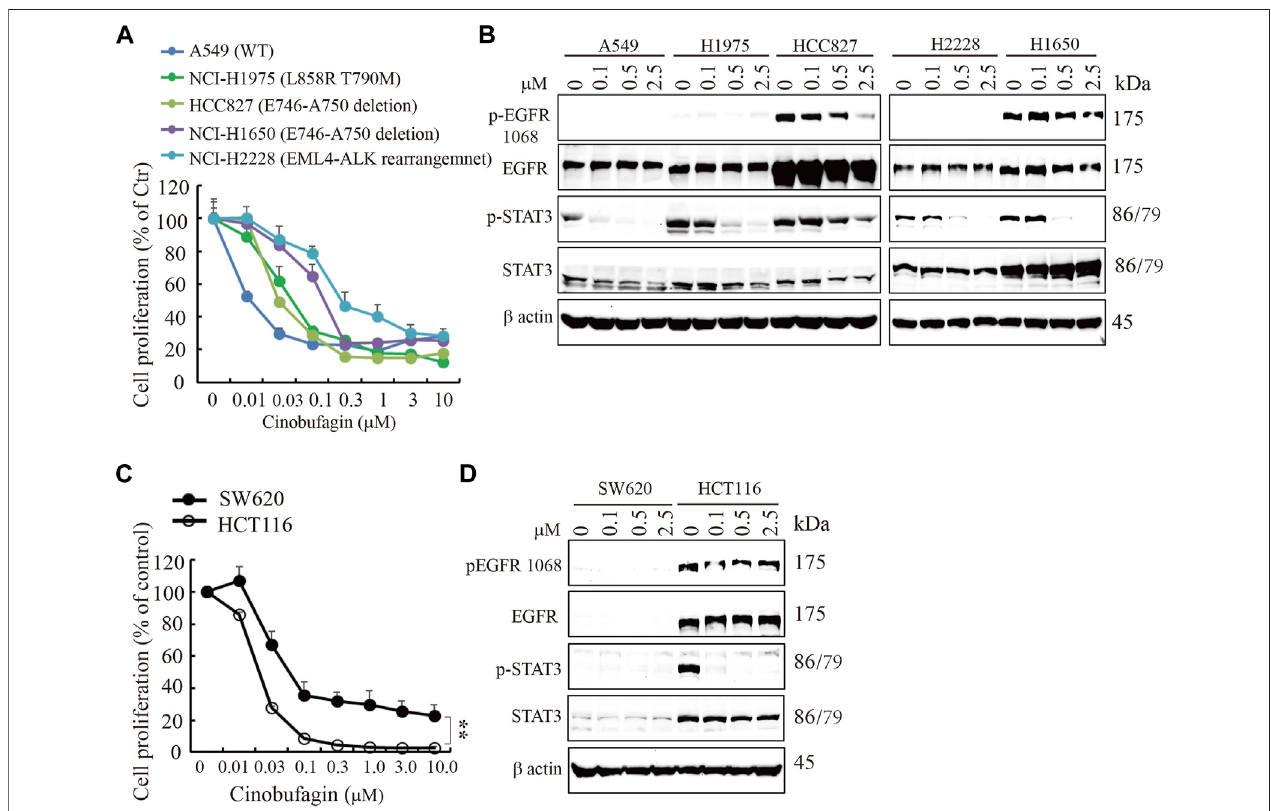
FIGURE 3 | Cinobufagin inhibits proliferation of EGFR expression cancer cells. (A) Cinobufagin inhibits proliferation of non – small lung cancer cell lines with EGFR expression. The non – small lung cancer cell lines with different status of EGFR were treated with a range of doses of cinobufagin for 72 h, followed by CCK8 assay. (B) EGFR expression and its downstream signaling analysis. The non – small lung cancer cell lines were treated with indicated doses of cinobufagin for 6 h, followed by Western blot analysis of EGFR and its downstream molecules. (C) Cinobufagin inhibits proliferation of colorectal cells with EGFR expression. Colorectal cells were treated with cinobufagin for 72 h, then followed by CCK8 assay. (D) EGFR expression and its downstream signaling analysis by Western blot. Colorectal cells were treated with indicated doses of cinobufagin for 6 h, followed by Western blot analysis of EGFR and its downstream molecules. Data are means ±